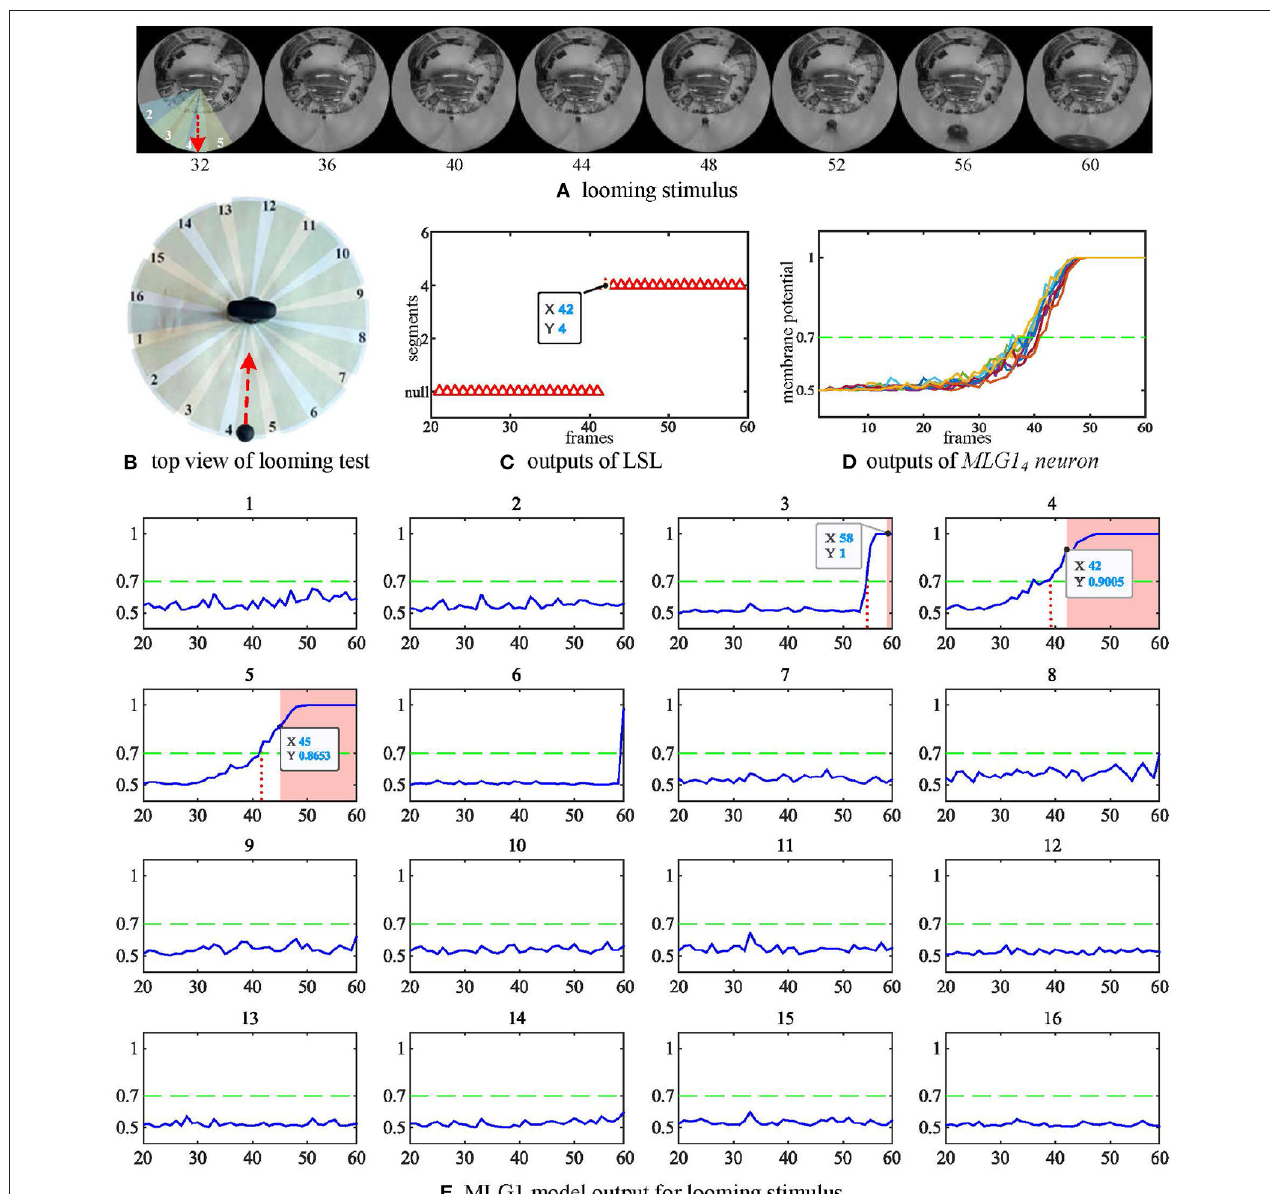
FIGURE 5 | Response of the proposed model to a looming stimulus. (A) Looming stimulus. The collision event occurred at the 60th frame. The red dashed line is the looming trajectory. (B) Top view of looming test. The red dashed line is the looming trajectory as same as in (A) . (C) The first outputs of LSL unit in this test. The LSL has no output until 42nd frame (i.e., MLG 1 4 firstly generates spike at this frame). (D) Outputs from MLG 1 4 neuron when challenged by repeated identical looming tests. The looming stimuli start from same position at similar speeds. (E) The response of the 16 MLG1 neurons from our proposed model. The blue lines are membrane potential of MLG1 neurons. Red area is collision warning. The number of each subgraph corresponds to the segment number within the proposed structure in (B) and Figure 3A . The Y-axis denotes a normalized membrane potential and the X-axis denotes the number of frames. The red vertical dashed line indicates the time at which the response output exceeds the threshold. The red area is the time window in which each MLG1 neuron generates spikes.